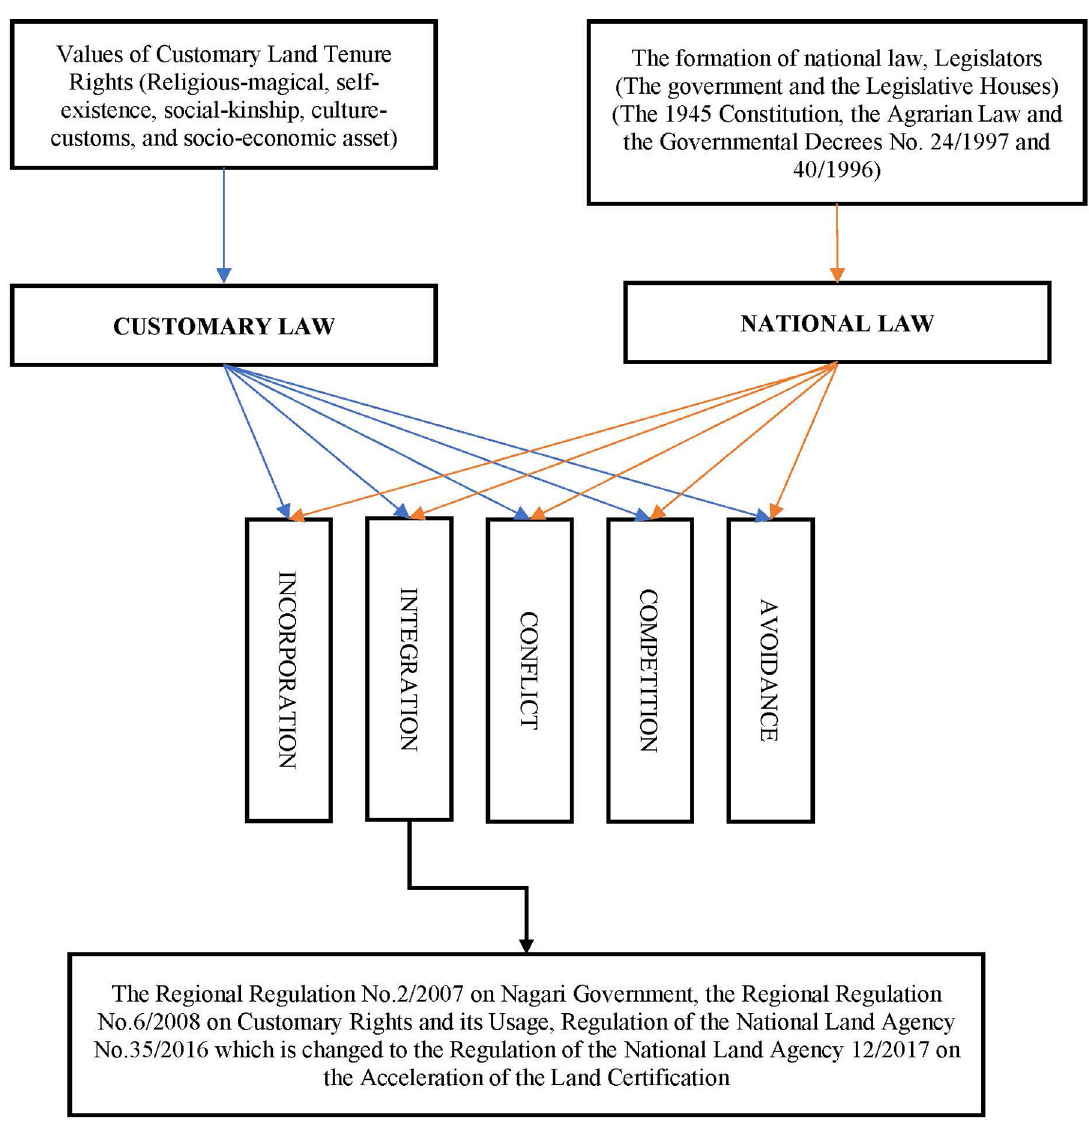
Figure 1. Interaction between the Customary Law and the National